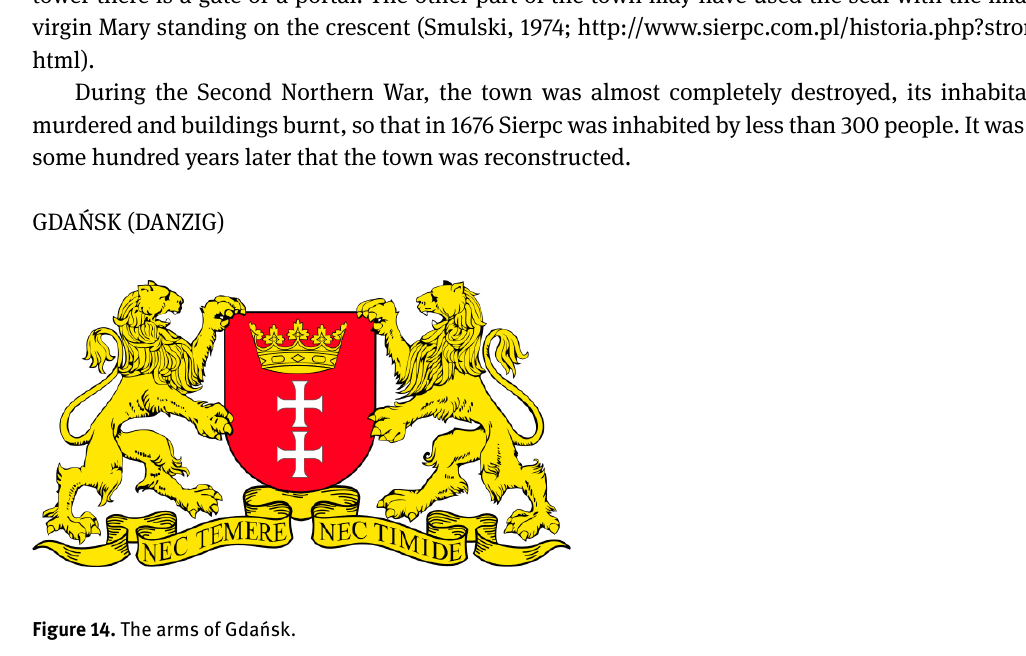
Figure 14. The arms of